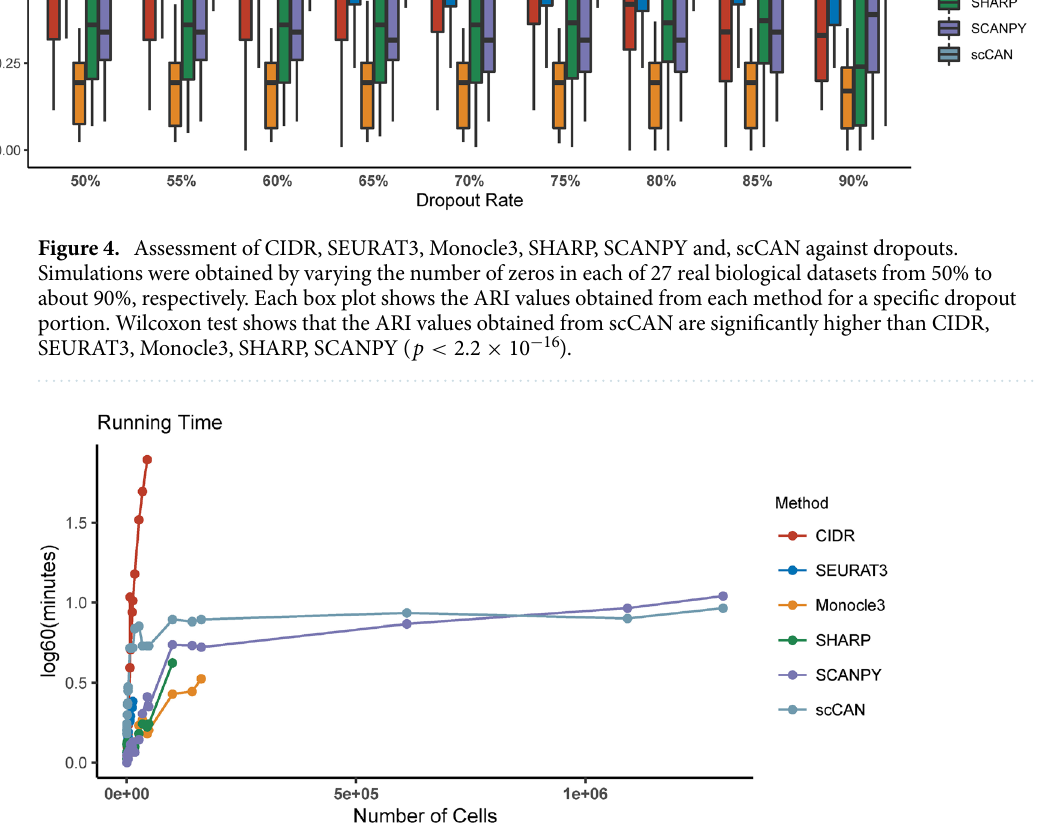
Time and space complexity.